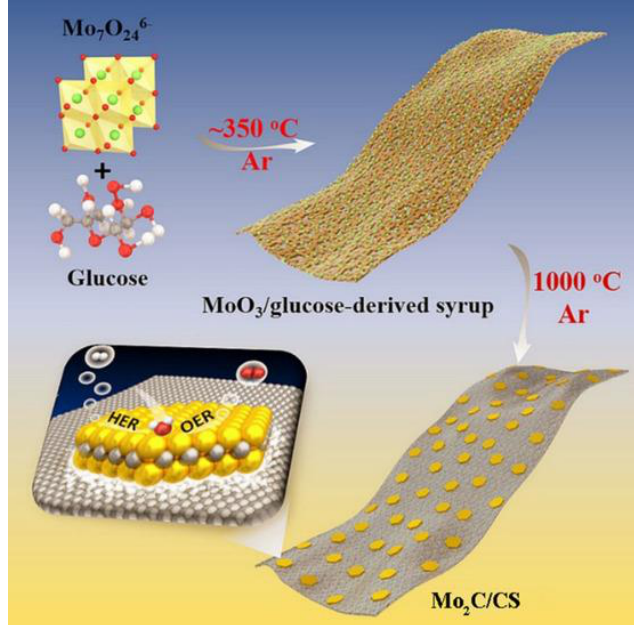
Figure 7. Schematic illustration of the synthetic process of an Mo 2 C@CS electrocatalyst for the oxygen evolution reaction. Reproduced with permission from [51]. Copyright 2017 ChemSusChem .